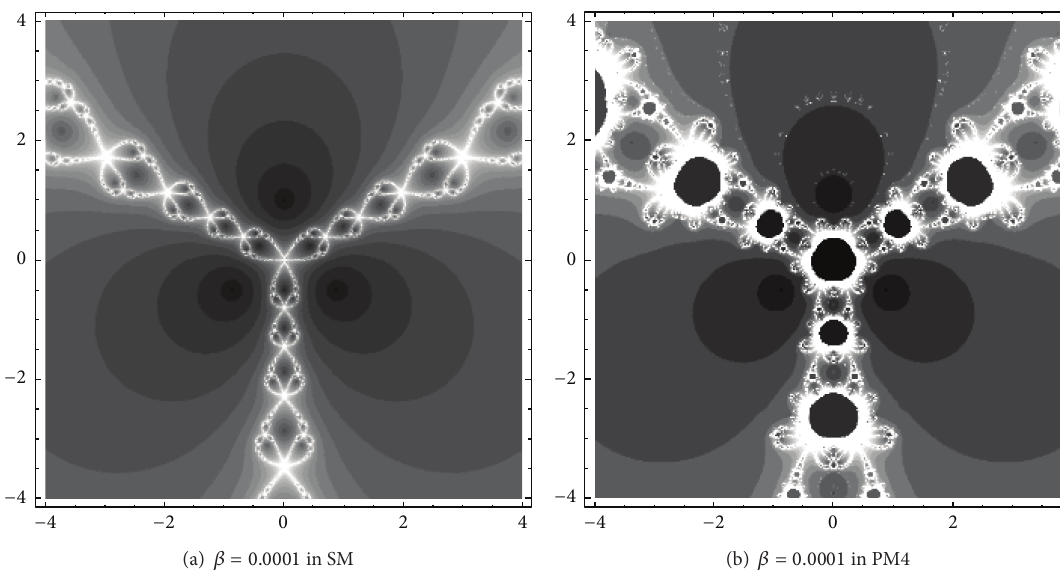
Figure 3: Attraction basins of the polynomial 𝑧 3 − 1 = 0 in the complex plane (shaded according to the number of iterations).